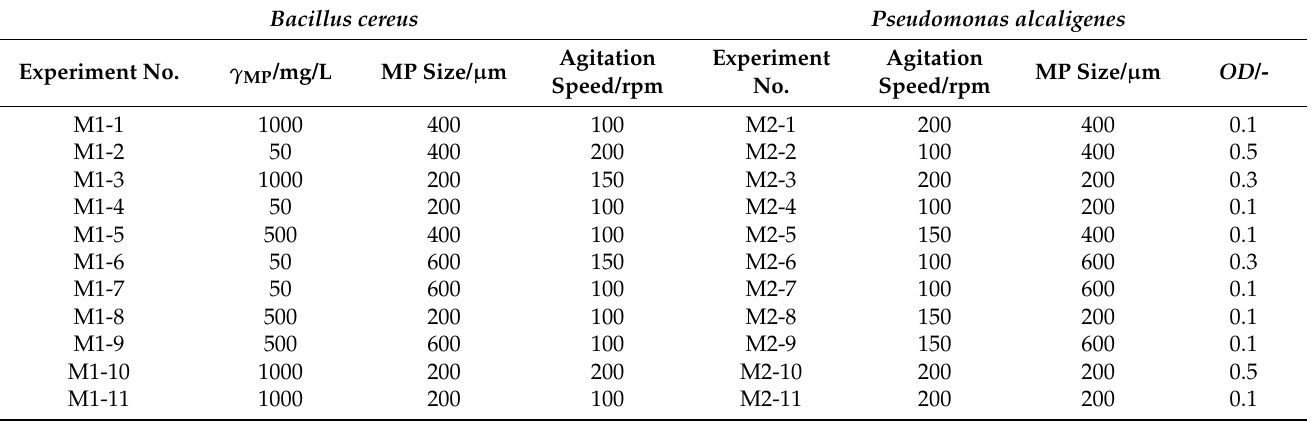
Table 2. Full factorial experimental design for MP-PS biodegradation process by bacteria Bacil- lus cereus and Pseudomonas alcaligenes at 3 levels. Bacillus